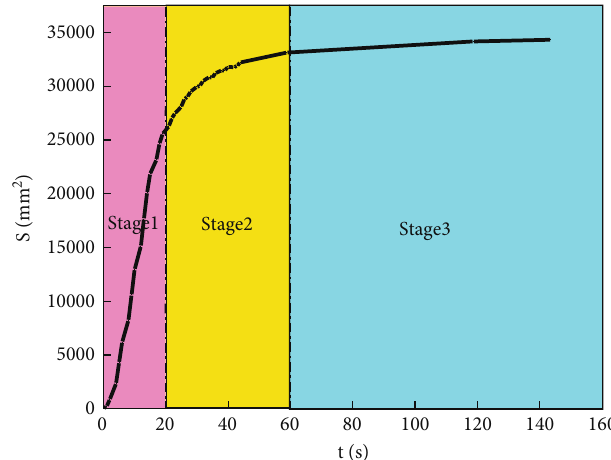
Figure 10: Area curve of PCE.